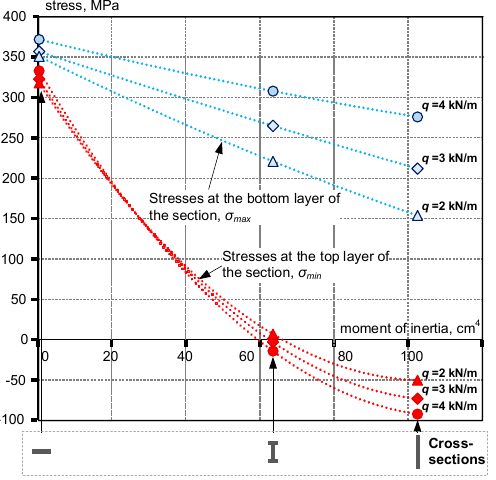
Figure 13. Extremum stresses in the cross-section having the maximum vertical displacement.